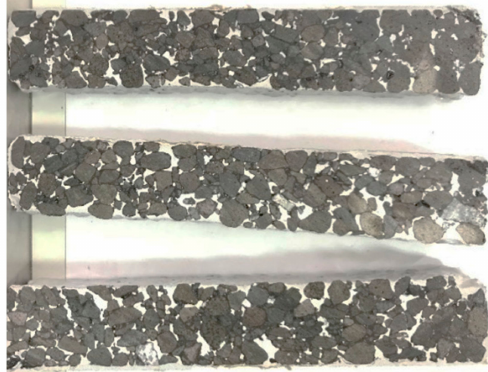
Figure 7. The beam specimens of the SFP